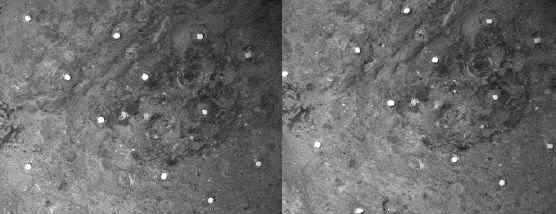
Figure 8: The stereo pair of one of the samples with